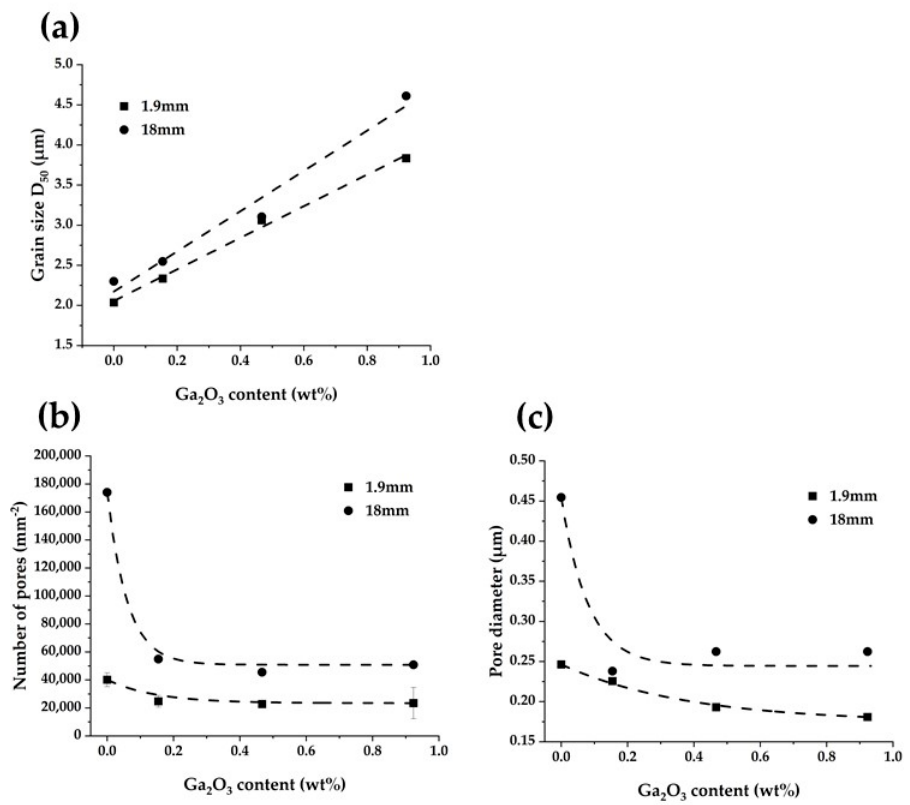
Figure 5. Relationship between ( a ) grain size, ( b ) number of pores, ( c ) pore diameter, and the Ga 2 O 3 concentration.